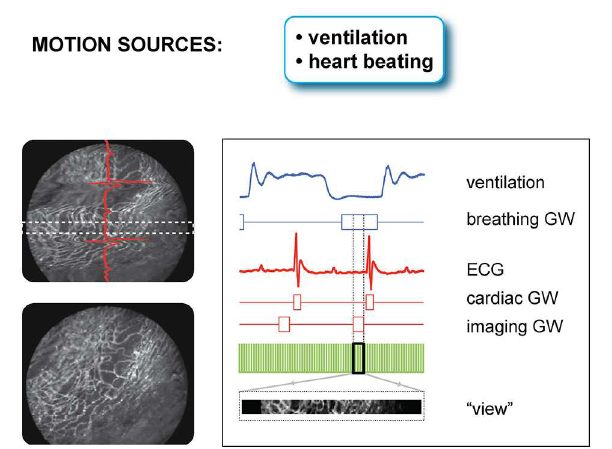
FIGURE 7 | Scheme of principle and timing diagram for retrospectively double gated (cardiac and respiratory) sequential segmented laser scanning microscopy. Due to the combined effect of cardiac and respiratory motion, segments from raw images need to be chosen in correspondence to a time-gated window, which is the intersection of two distinct temporal windows present in the ECG and the ventilator pressure diagram. Adapted from Lee et al. (2012a).